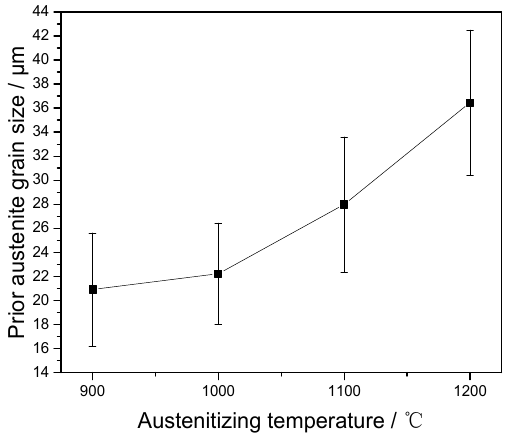
Figure 6. Measured prior grain sizes of austenite of the samples upon different austenitizing temperatures.